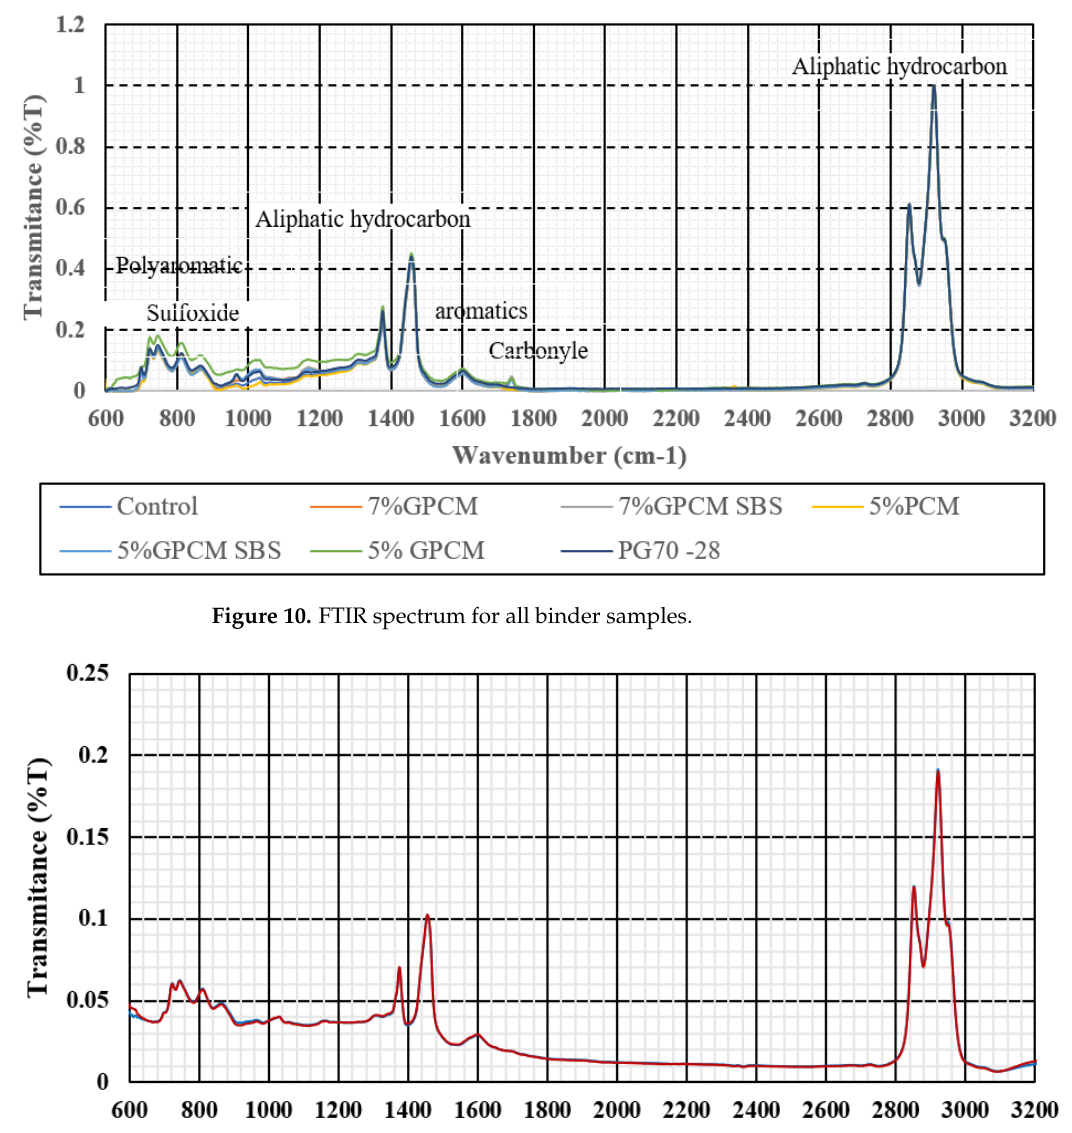
Figure 12. DSC diagram for control, 5%PCM, and 5%GPCM binders. For each binder, the bottom curve represents the heating phase of the cycle, whereas the top curve represents the cooling phase of the cycle, as shown in Figure 12. Two main components were considered on the heating/cooling curves: the temperature at which the peaks occurred (phase transition) and its corresponding heat flow. It was found that the PCMs and GPCM had a visible effect on the thermal behaviour of the modified binders. As shown in Figure 12, the heat flow released from the 5%PCM was 0.335 W/g at−15 °C. However, it was noticed that the released heat flow by the ­15.92°C